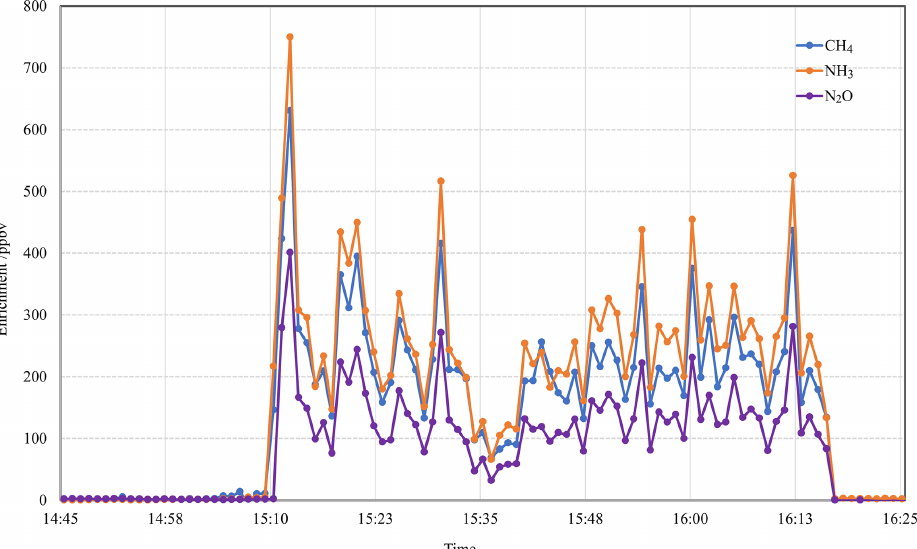
Figure 5. Measured OP-FTIR 1min averaged mole fractions of CH 4 , N 2 O, and NH 3 after subtracting the background levels during a point-source gas release experiment at Kyabram on 27 July 2005.